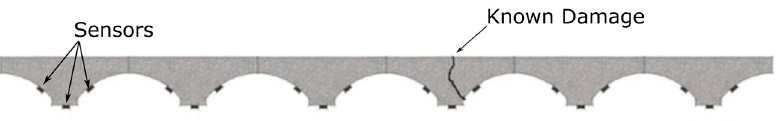
Figure 5. Sample of sensors set up on SHB [112].